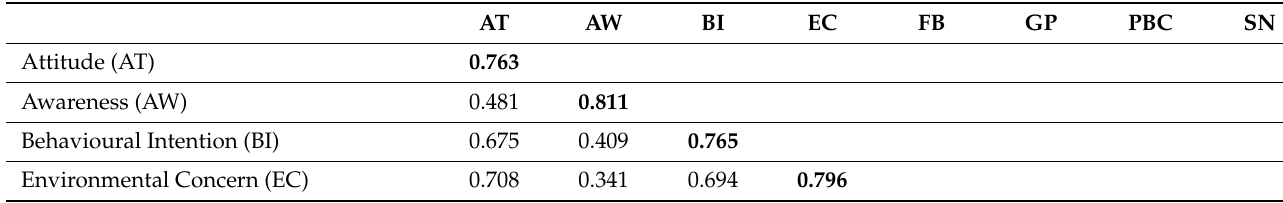
Table 3. Fornell-Larcker